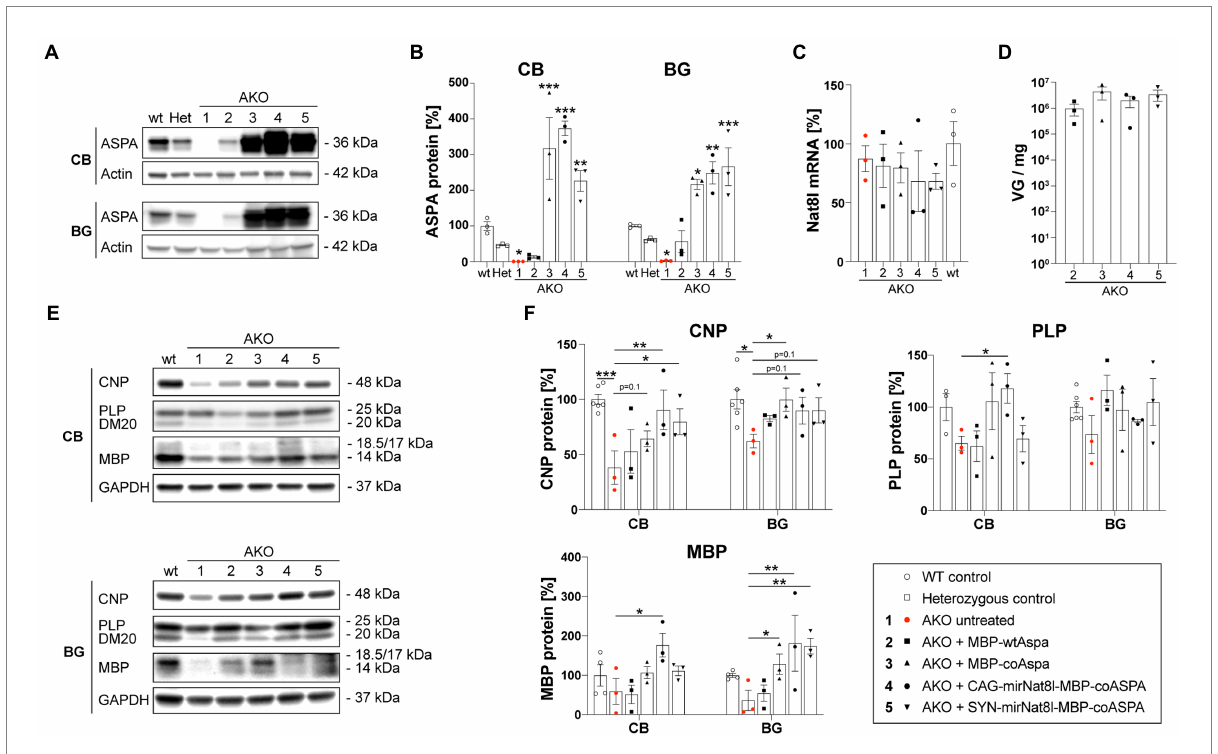
FIGURE 8 Restored myelin protein expression in AKO mice following dual-function gene therapy. AAV vectors were injected bilaterally into striatum, thalamus, and cerebellum (3 × 10 9 vg per site) of 12-week-old post-symptomatic AKO mice. (A) Western blot showing ASPA expression in the cerebellum (CB) and basal ganglia (BG; including striatum and thalamus) of one-year-old mice 40 weeks post gene therapy. (B) Densitometric quantification of ASPA protein levels normalized to the housekeeper Actin and wildtype controls ( n = 3). (C) Nat8l mRNA expression levels in the brain of one-year-old mice 40 weeks post gene therapy. Displayed are ΔΔ Ct values normalized to the housekeeping gene GusB and wildtype controls ( n = 3). (D) AAV vector load in the brain of one-year-old mice 40 weeks post gene therapy measured as viral genomes per mg of brain tissue ( n = 3). (E) Western blot depicting expression levels of the mayor myelin proteins CNP, PLP/DM20 and MBP as well as the housekeeping protein GAPDH in the CB and BG region of one-year-old mice 40 weeks post gene therapy ( n = 3). (F) Densitometric quantification of the myelin proteins CNP, PLP and MBP normalized to the housekeeper GAPDH and wildtype controls ( n = 3). Data represent mean ± SEM. * p < 0.05,** p < 0.01, *** p < 0.001; Two-way ANOVA with Bonferroni post-hoc